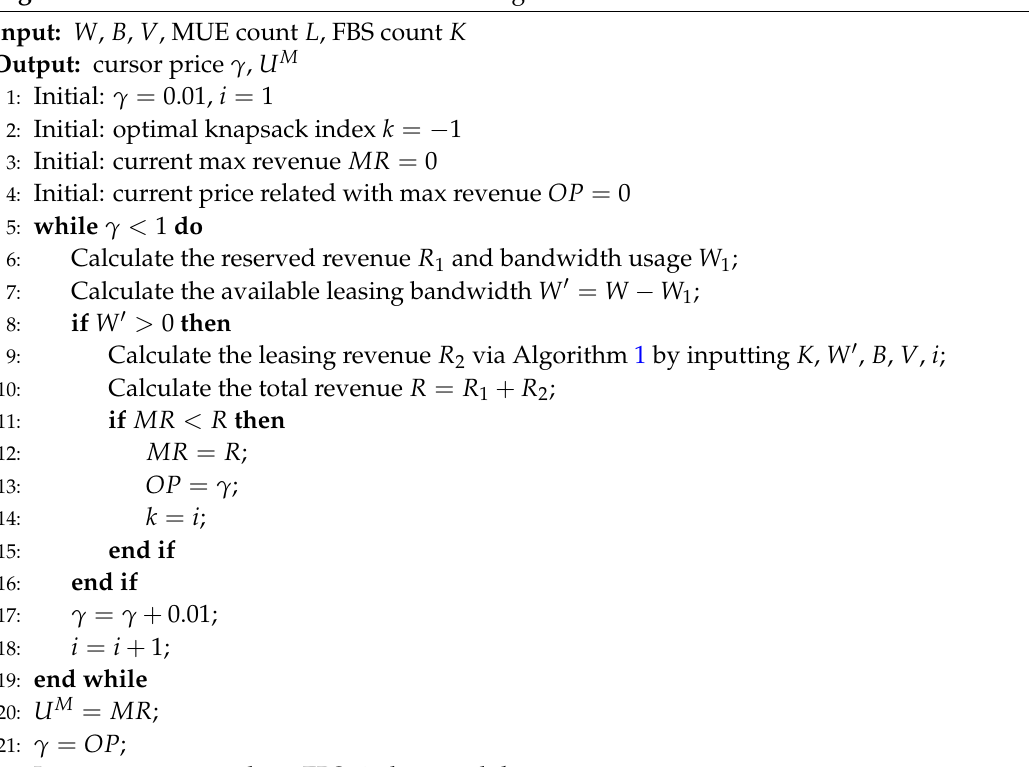
Algorithm 2 Price and winner determination